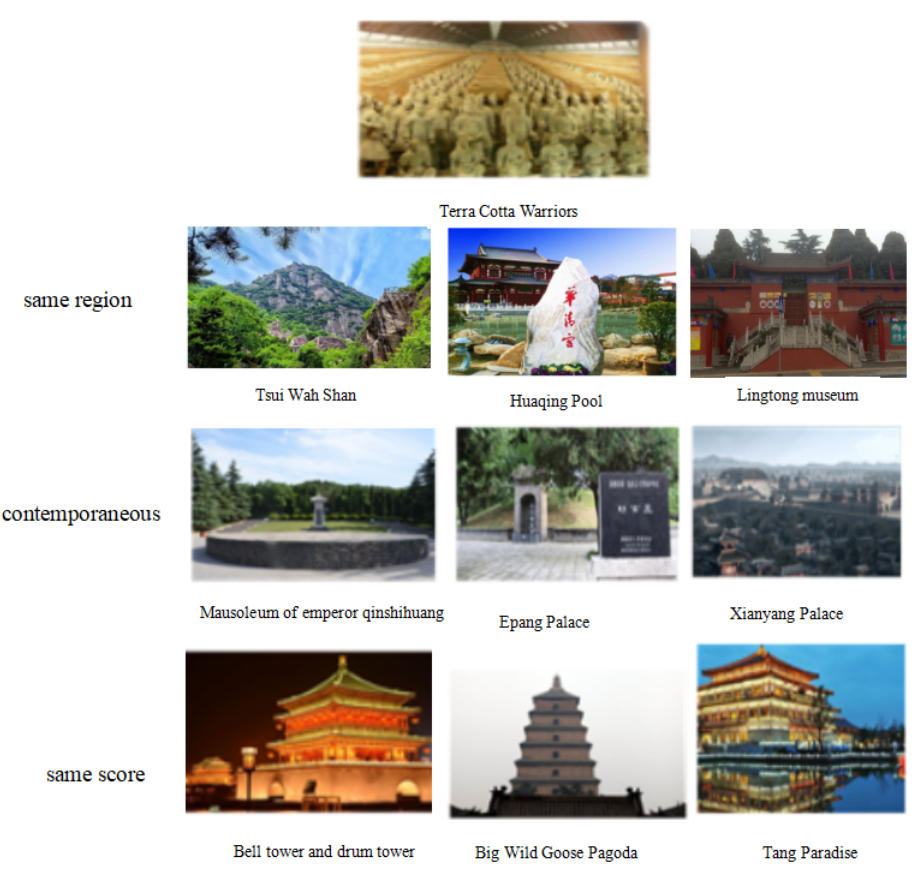
Figure 8. Examples of recommended results’